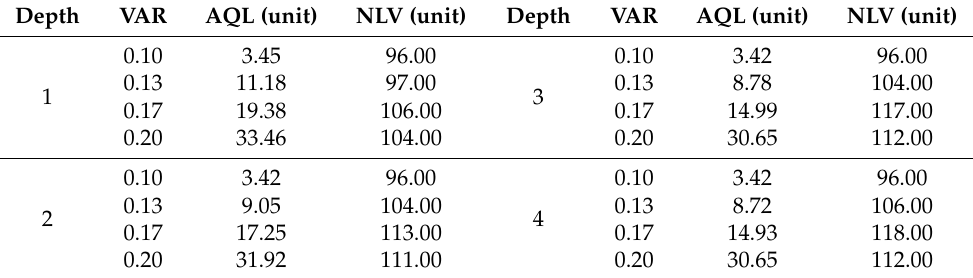
Table 5. Performance of ISM under different search